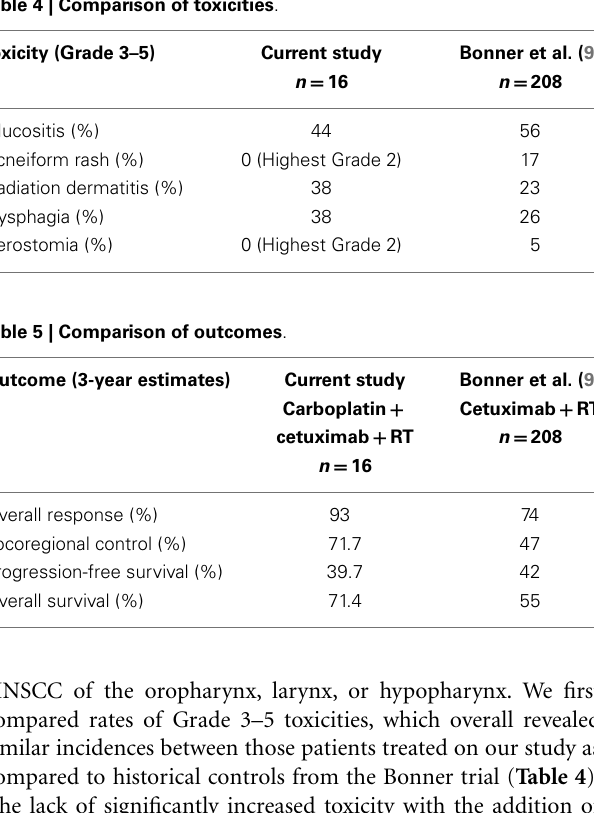
Table 4 | Comparison of toxicities .